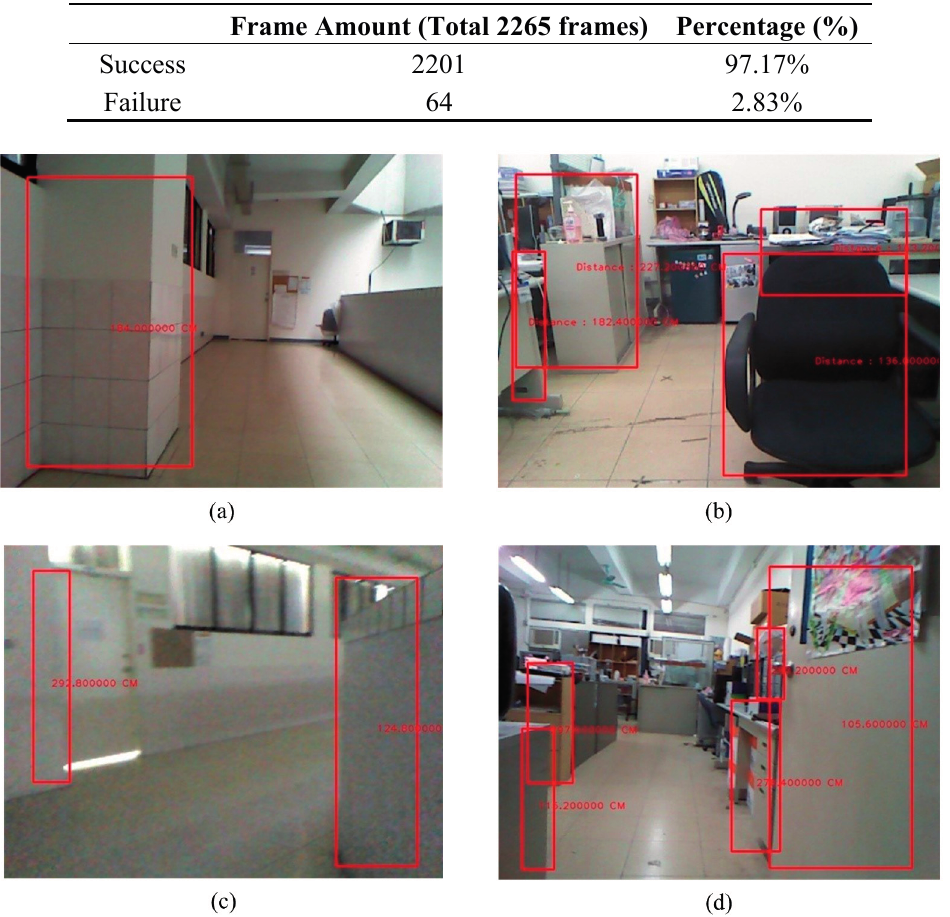
Figure 21. The detection of an obstacle indoors under sufficient light. ( a ) Corridor 1; ( b ) Laboratory 1; ( c ) Corridor 2; ( d ) Laboratory